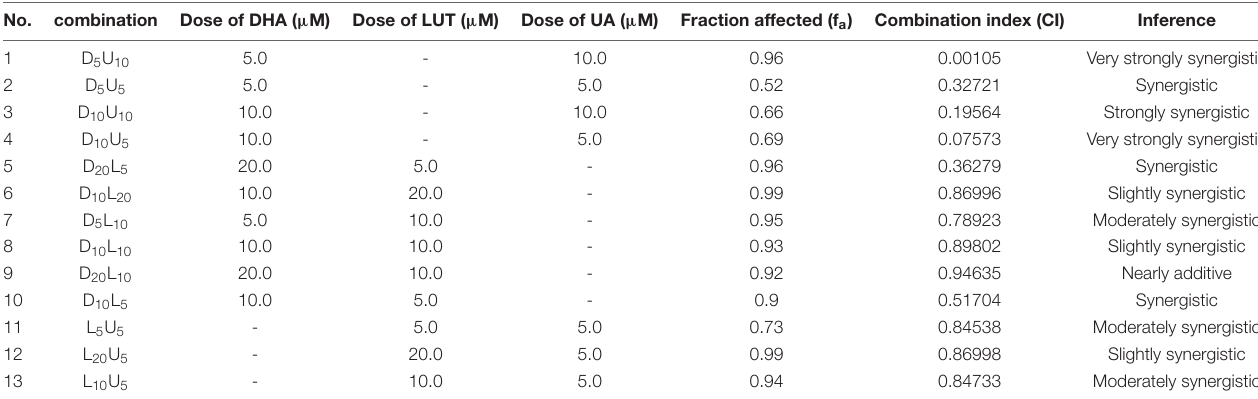
TABLE 1 | In silico -derived synergistic two-compound combinations.